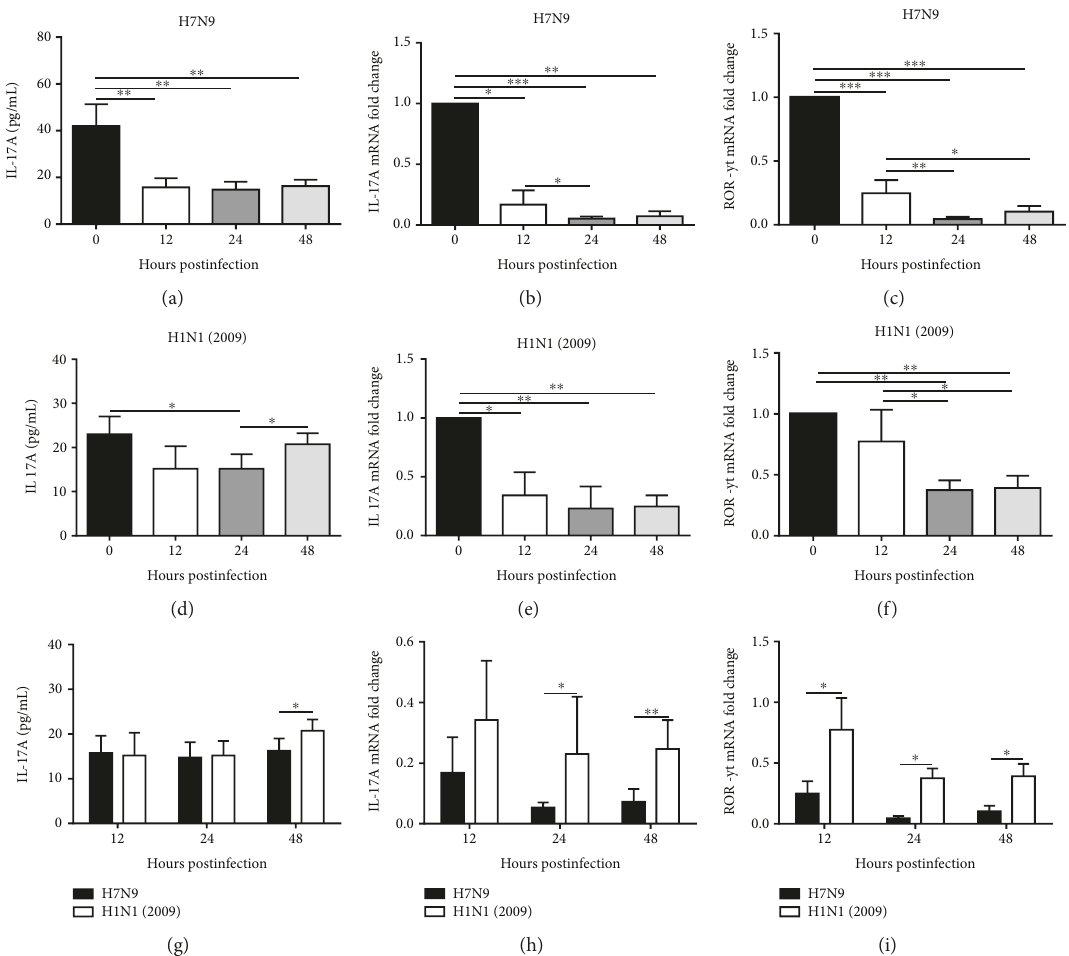
Figure 4: Reduced IL-17A protein and mRNA expression in PBMCs infected with the H7N9 virus in vitro . (a – c) Changes in IL-17A protein (a), IL-17A mRNA (b), and ROR- γ t mRNA (c) levels after infection with the H7N9 virus at the indicated time points. (d – f) Changes in IL- 17A protein (d), IL-17A mRNA (e), and ROR- γ t mRNA (f) levels after infection with the H1N1(2009) virus at the indicated time points. (g – i) Comparison of IL-17A protein (g), IL-17A mRNA (h), and ROR- γ t mRNA (i) levels after infection with the H7N9 and H1N1(2009) viruses at the indicated time points. ∗ P < 0 05 , ∗∗ P < 0 01 , and ∗∗∗ P < 0 001